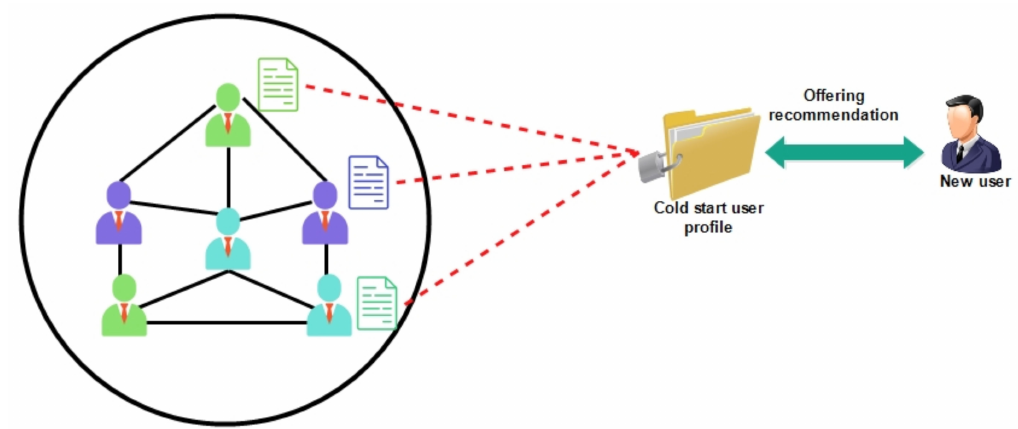
Figure 3. Understanding of similar or connected user profiles used as auxiliary information for building cold start user profile to enable similar